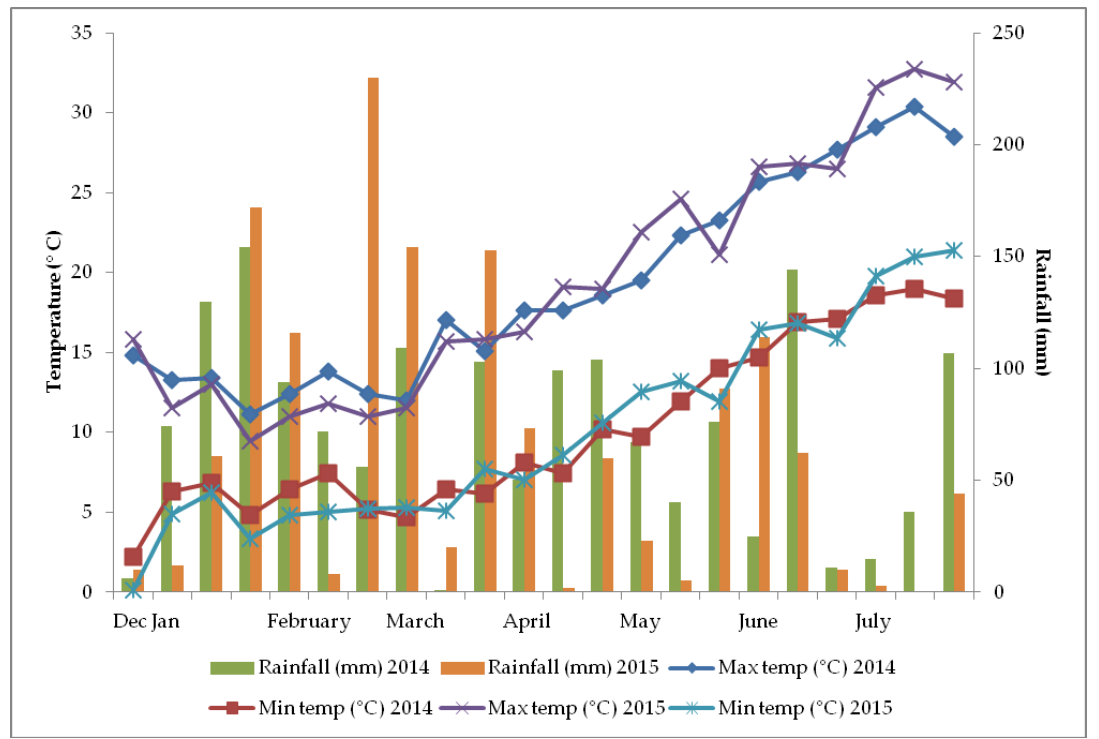
Figure 6. Trend of temperature and rainfall in Montoro (Avellino, southern Italy) in 2014 and